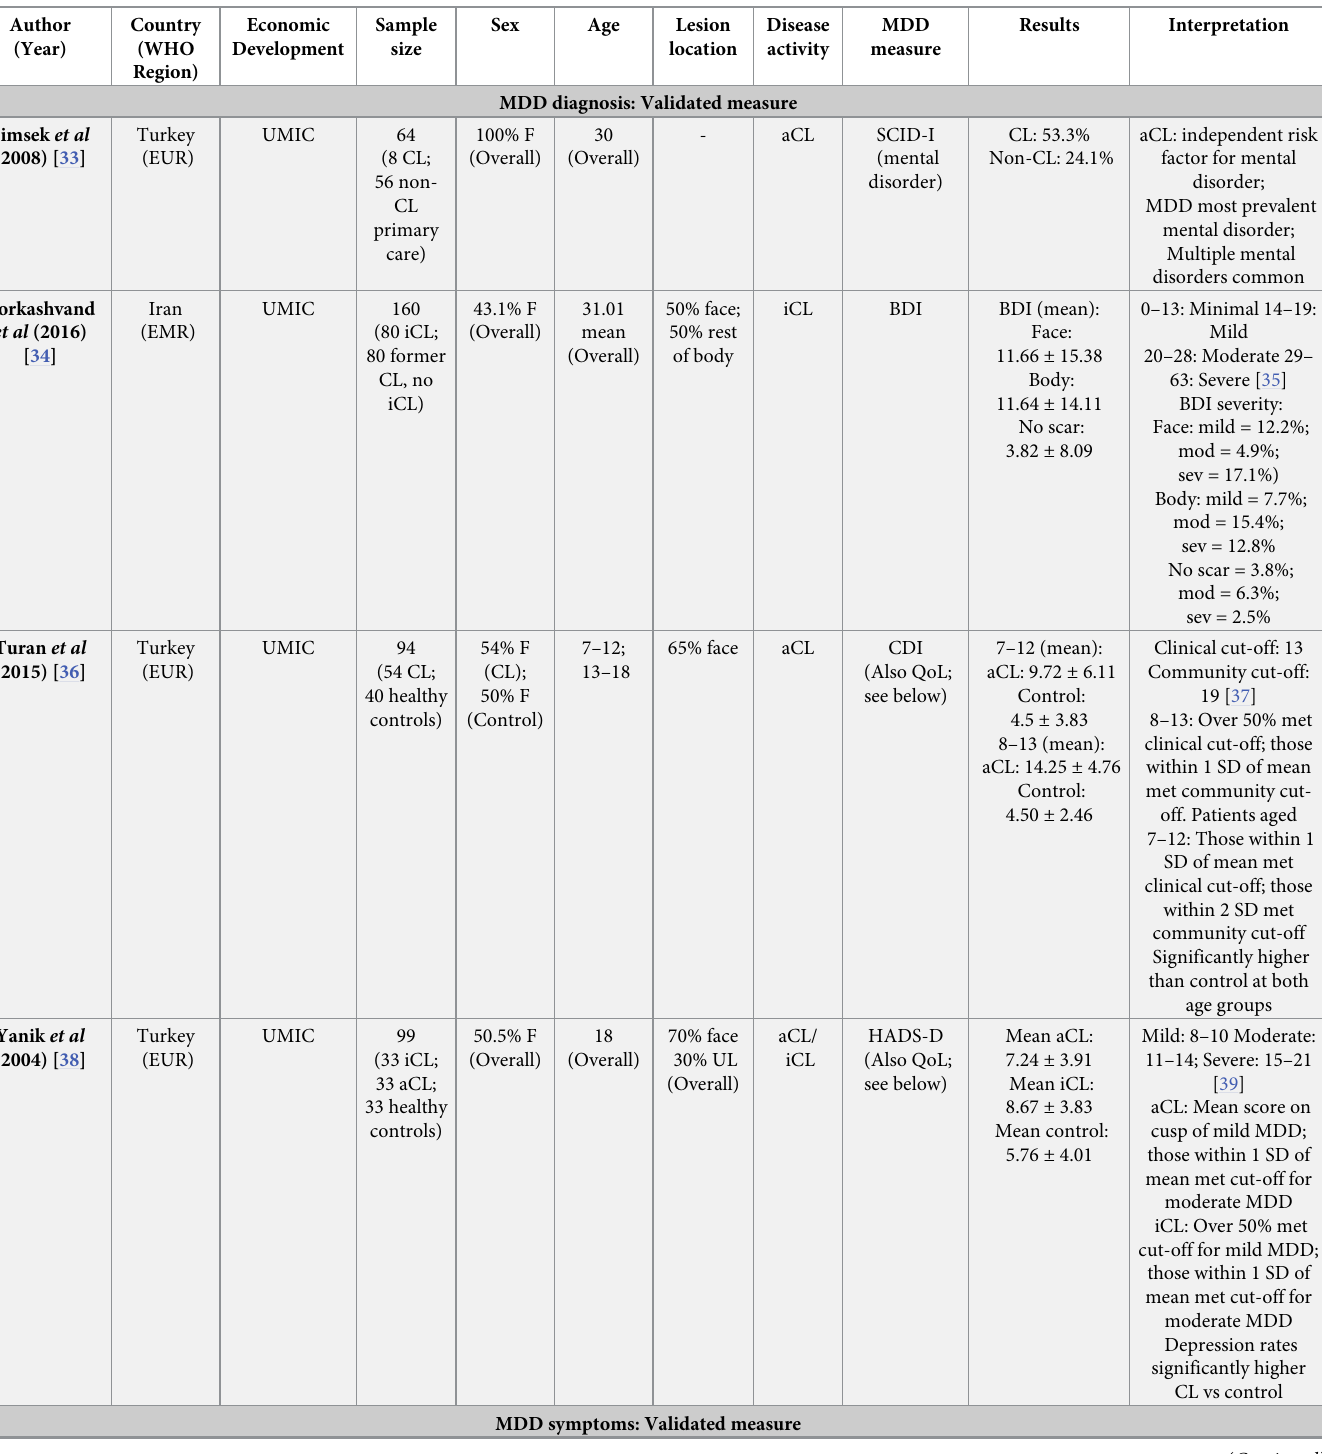
Table 1. Quantitative studies: MDD diagnosis and symptoms (validated and non-validated